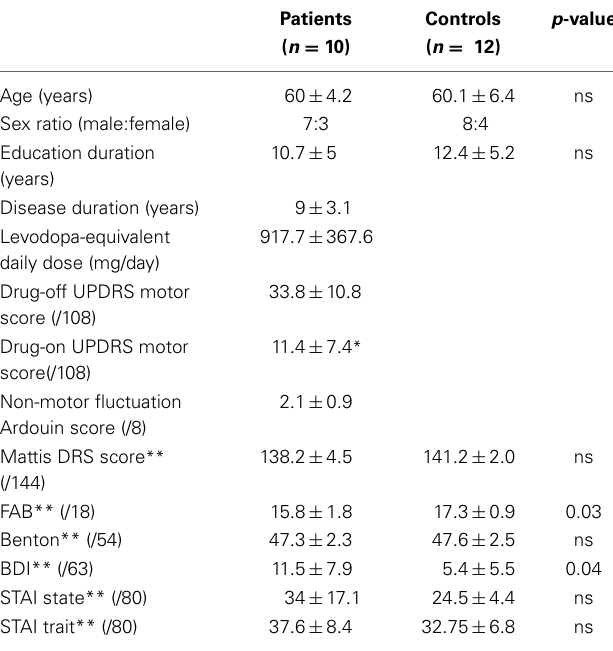
Table 1 | Demographic and clinical characteristics of